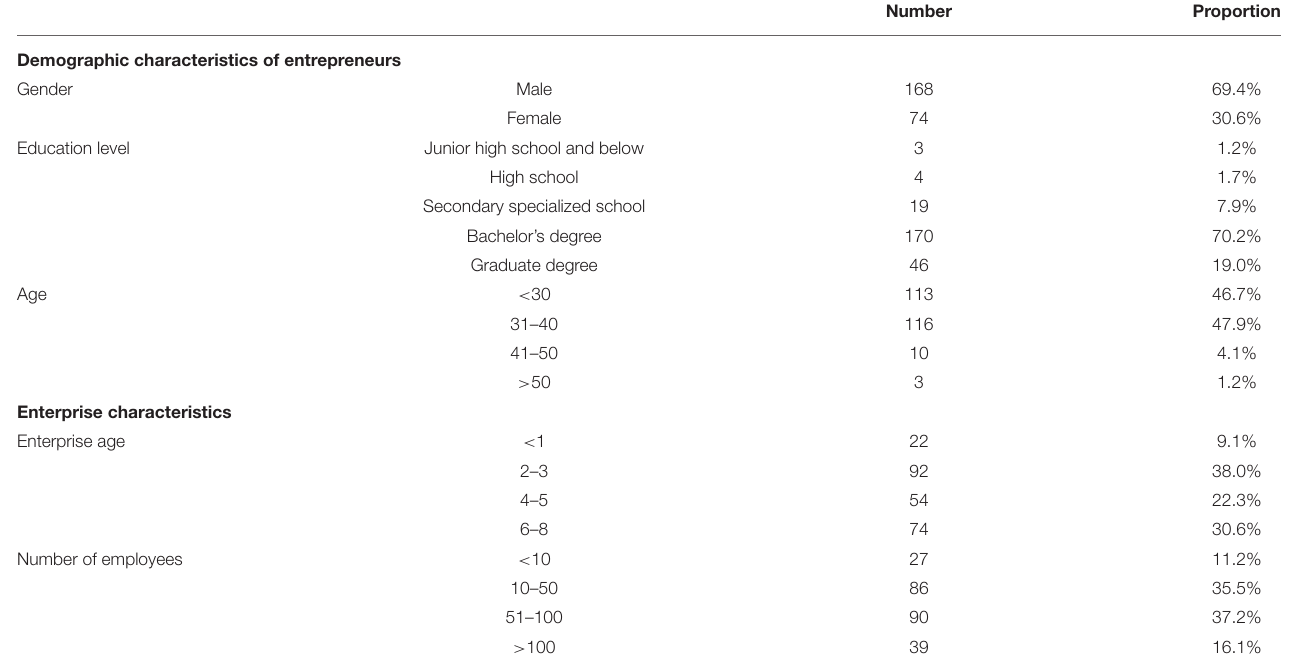
TABLE 1 | Basic information of questionnaire ( n =